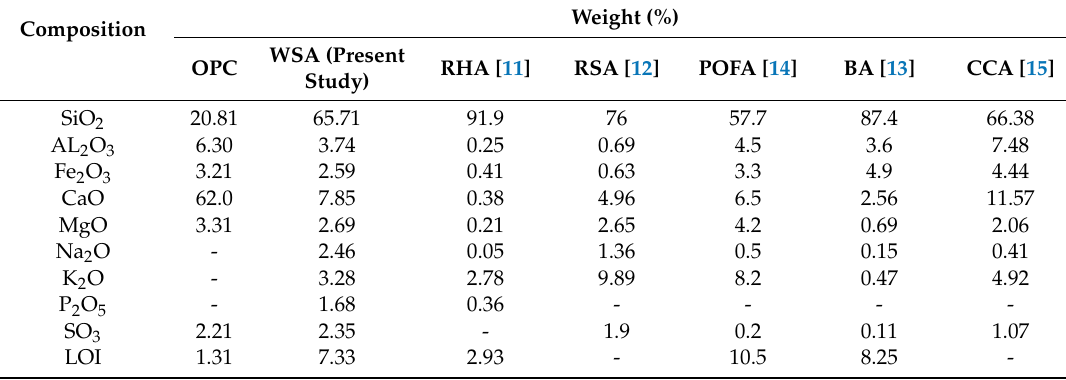
Table 1. Chemical composition of used WSA and other ARAs.